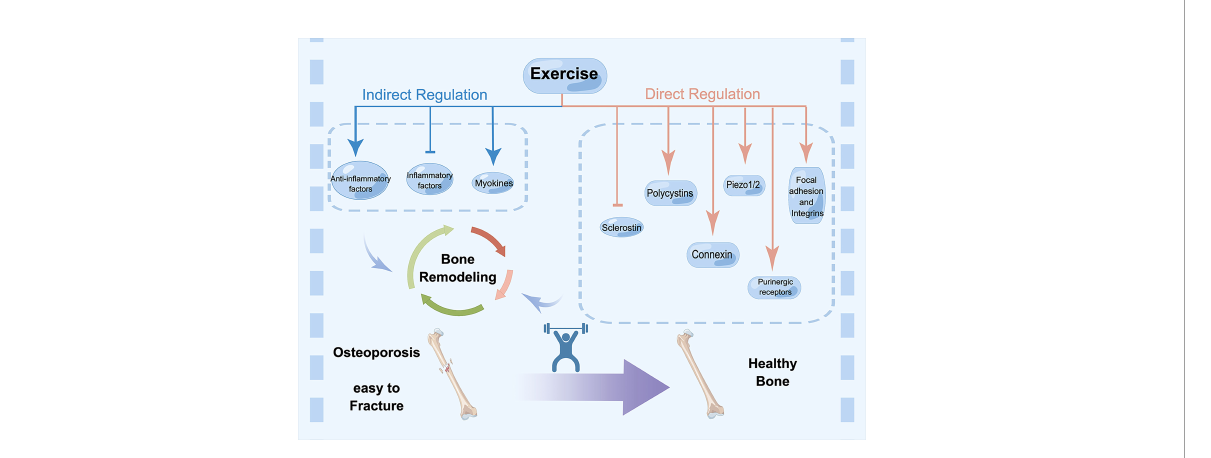
FIGURE 1 Direct and indirect regulation mechanisms of exercise for osteoporosis. Cell surface receptors are the starting point for understanding the regulatory effects of mechanical loading, which include focal adhesions, integrins, purinergic receptors, connexin, polycystins, Piezos, Wnt signaling and sclerostin. In addition, exercise-induced regulation of bone environment also occurs through cytokines, including in fl ammatory factors and myokines, such as irisin. These factors affect bone remodeling collectively. Exercise promotes bone mass and sustain healthy bone, while lacking exercise results in osteoporosis and